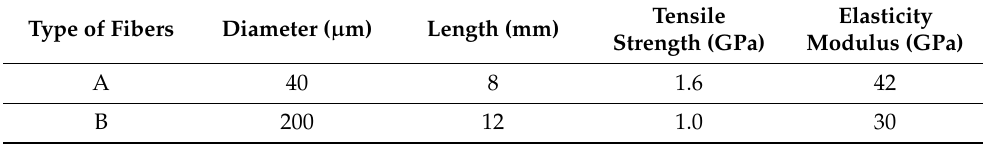
Table 4. Characteristics of PVA